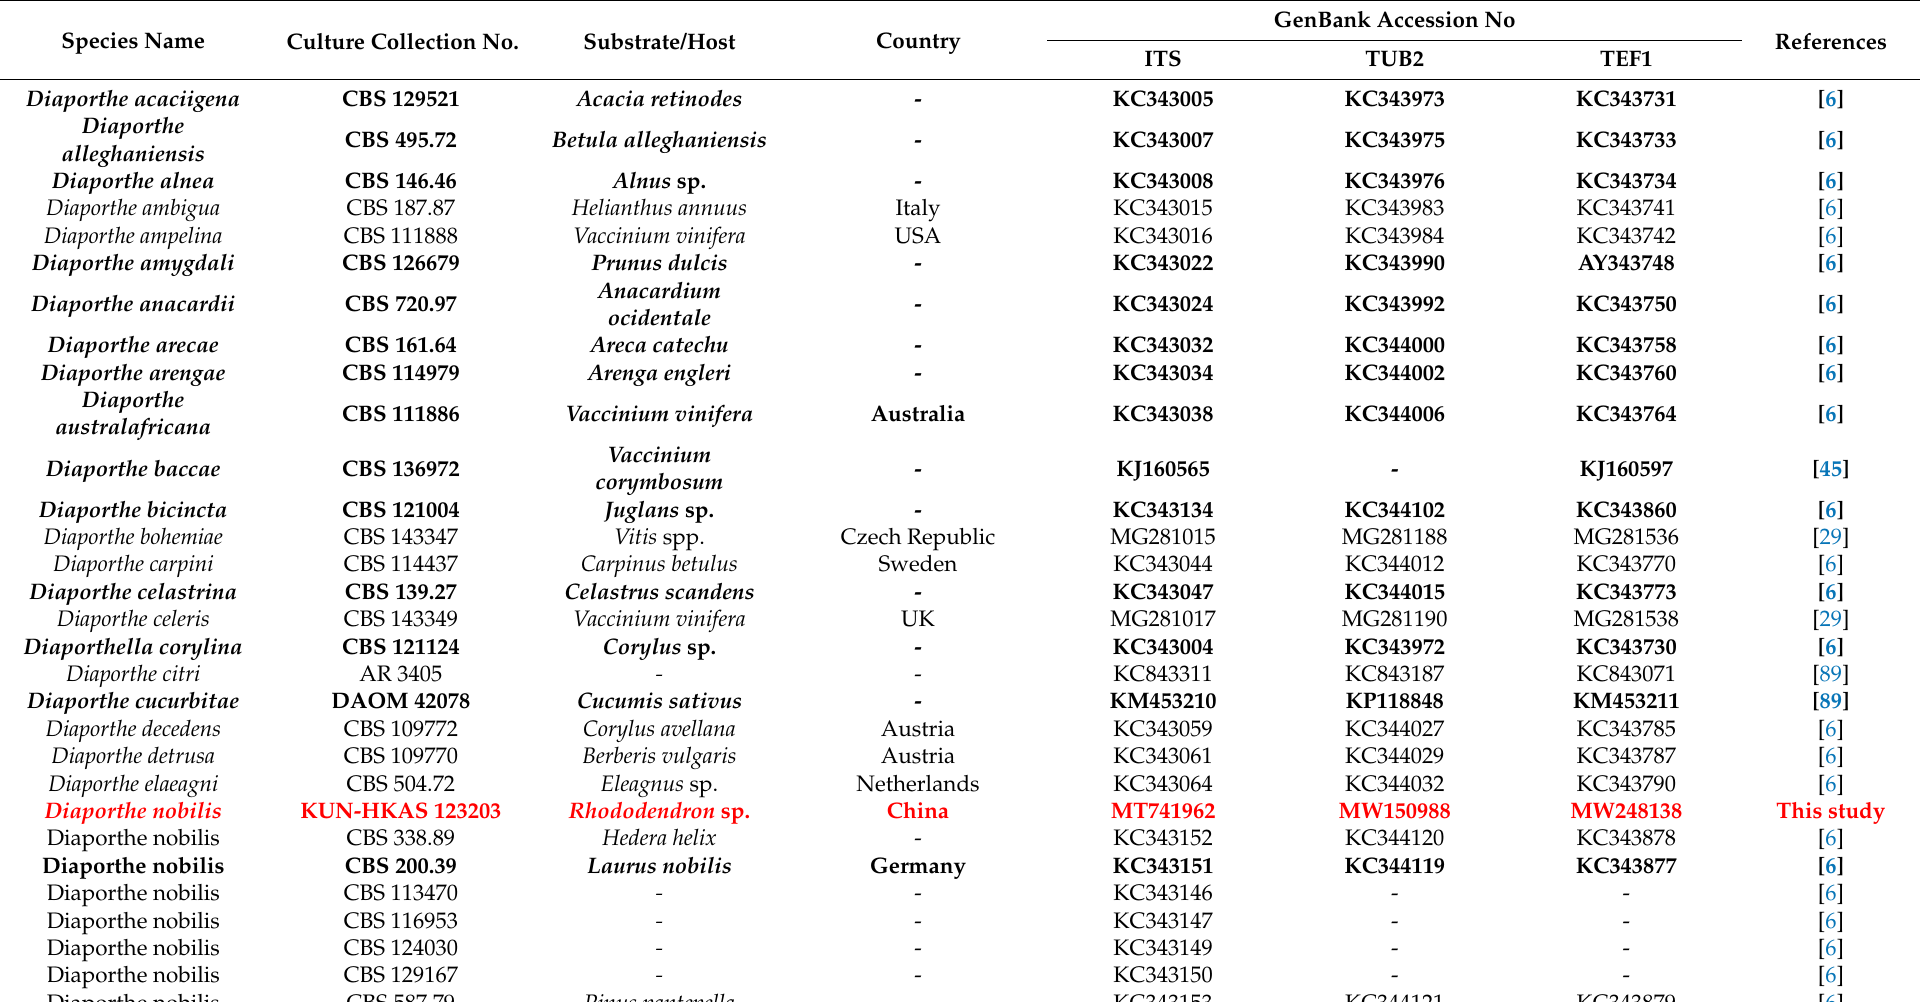
Table 3. Culture collection numbers and GenBank accession numbers for Diaporthe used in this study. The type species are indicated in bold. The newly